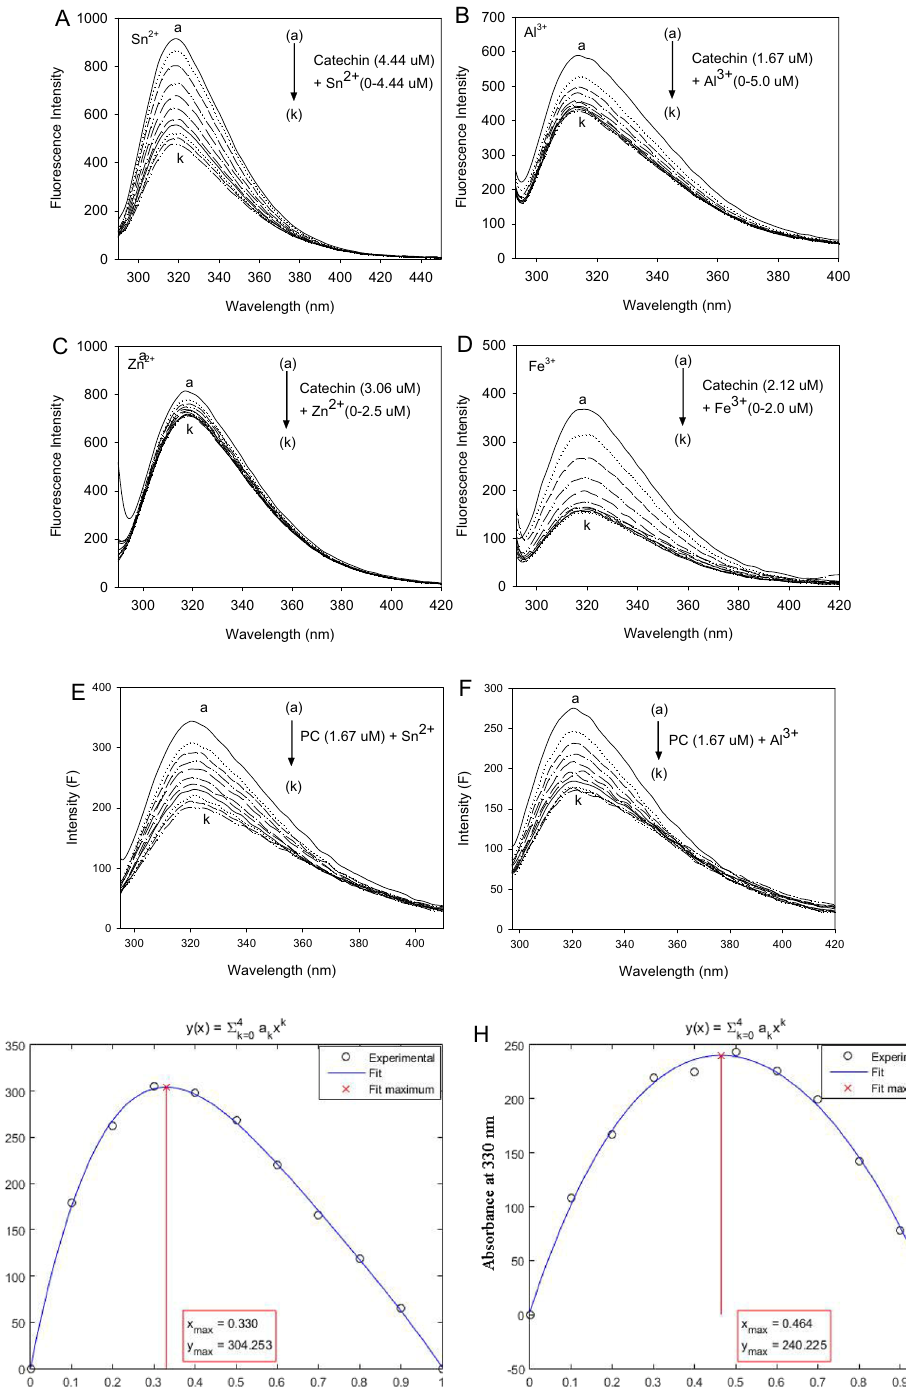
Figure 4. The fluorescence quenching spectrum of catechin at various concentrations of ( A ) Sn 2+ , ( B ) Al 3+ , ( C ) Zn 2+ and ( D ) Fe 3+ , λ ex , 280 nm; The fluorescence quenching spectrum of PC at various concentrations of ( E ) Sn 2+ and ( F ) Al 3+ . λ ex , 280 nm; c (PC), 1.67 μM; c (metal ions) (a → k), 0.0, 0.05, 0.1, 0.15, 0.2, 0.25, 0.3, 0.35, 0.4, 0.45, 0.5 μM; The binding stoichiometry of ( G ) catechin and ( H ) PC with Fe 3+ (Using Job’s